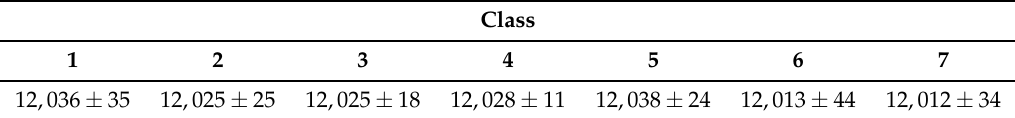
Table 1. Alphabet size (mean ± standard deviation).